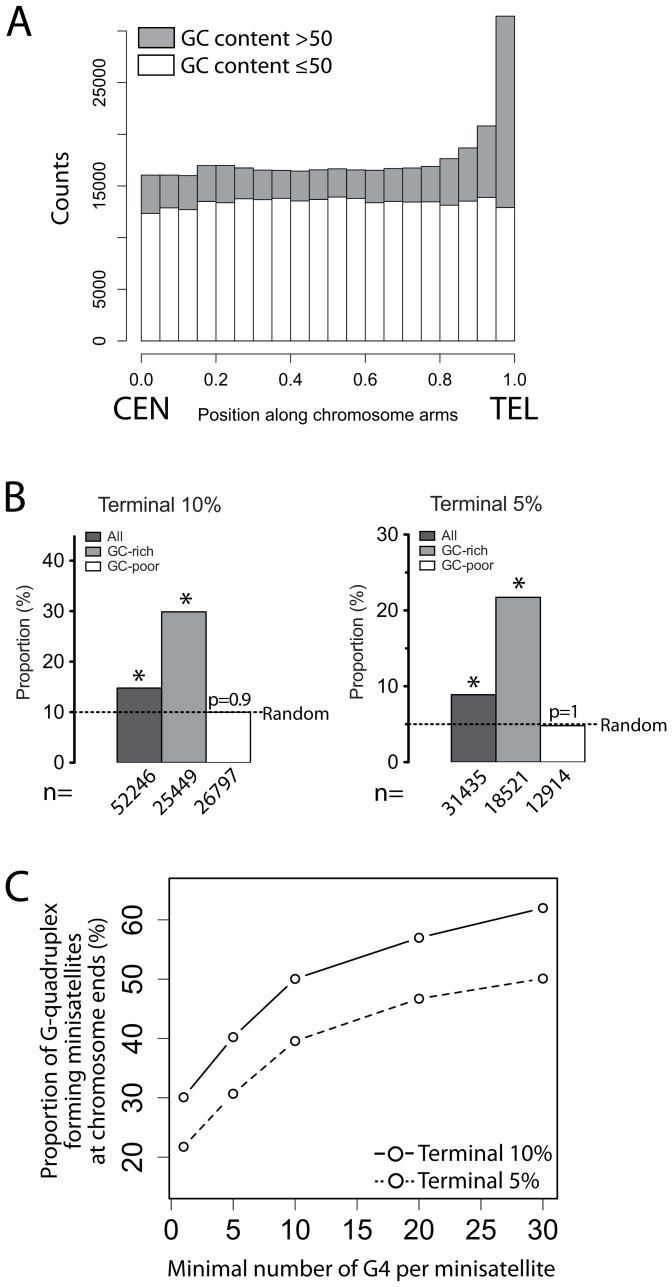
GC–rich and G-quadruplex-forming minisatellites are enriched at chromosome ends in the human genome.(A) Distribution of the human minisatellites along a normalized chromosome arm in the human genome. The centromere (CEN) is at 0, and the telomere (TEL) at 1. (B) Proportion of the GC-rich (GC content >50%), GC-poor (GC content ≤50%), and all the minisatellites in the terminal 10 and 5% on each chromosome arms. n indicates the number of minisatellites. A star (*) indicates a significant enrichment (all p-values <2e−16). No enrichment is observed for GC-poor minisatellites. (C) Proportion of minisatellites in the terminal 10% (continuous line) and 5% (dotted line) of chromosome arms as a function of the number of non-overlapping G-quadruplex-forming sequences per minisatellite.